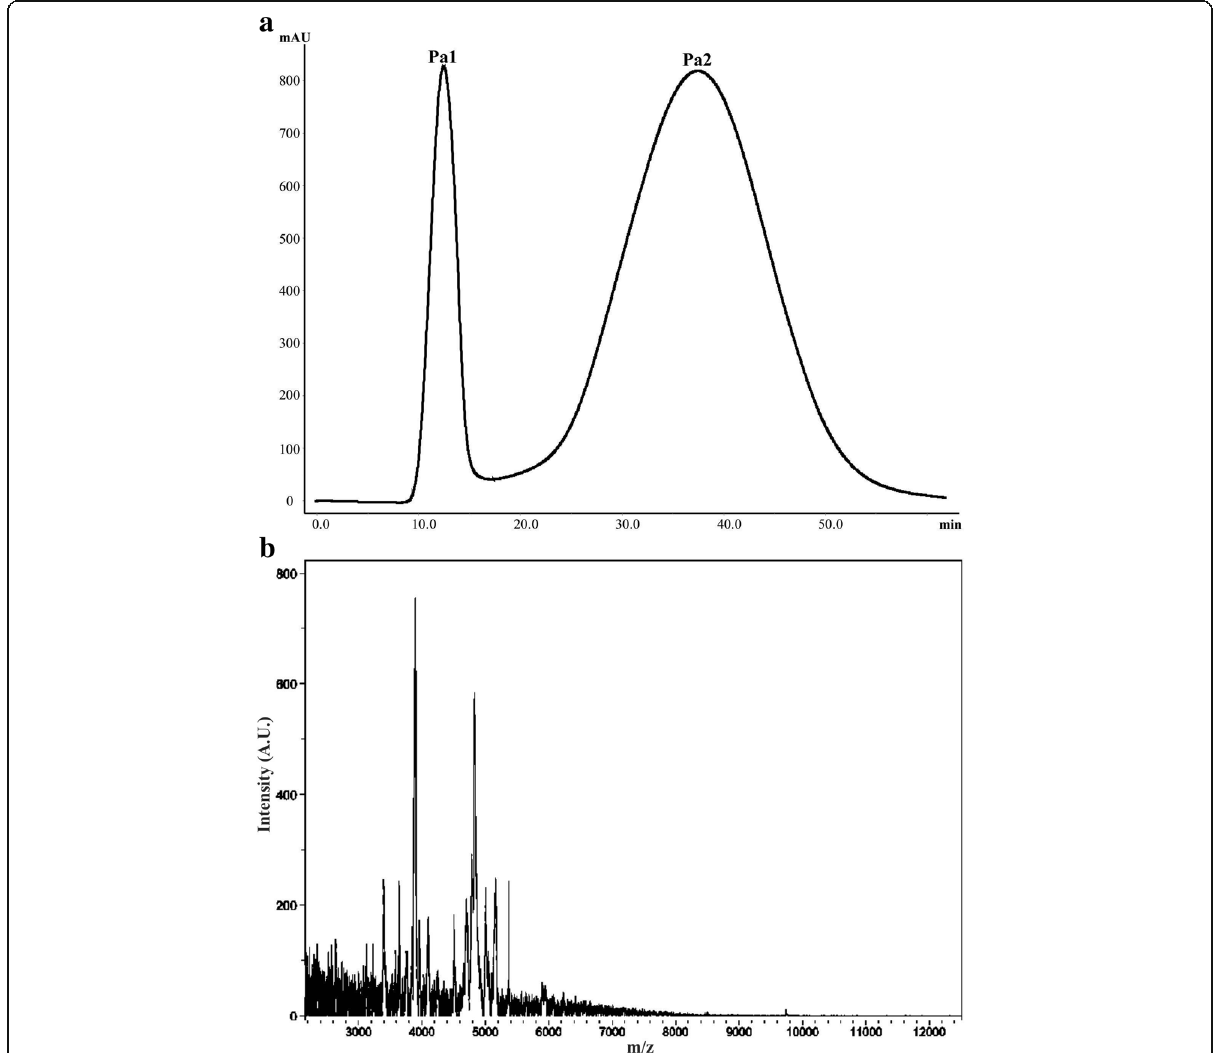
Fig. 7 a P. astreoides extract elution profile obtained by FPLC on a Sephadex G-50 column at 280 nm. The column was equilibrated and eluted with 1.6 mM acetic acid at 1 mL/min. b MALDI-TOF of the second fraction (Pa2) after filtration with ultra-centrifugation filters with 10 K